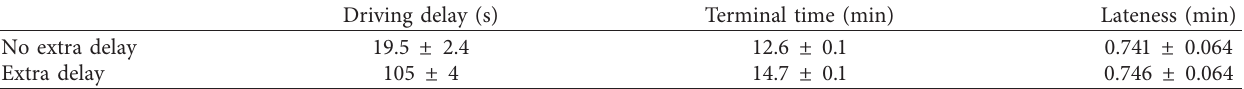
Table 3: Results for the longer delay at the south-west exit scenario in the form of average values with 95% confidence intervals.